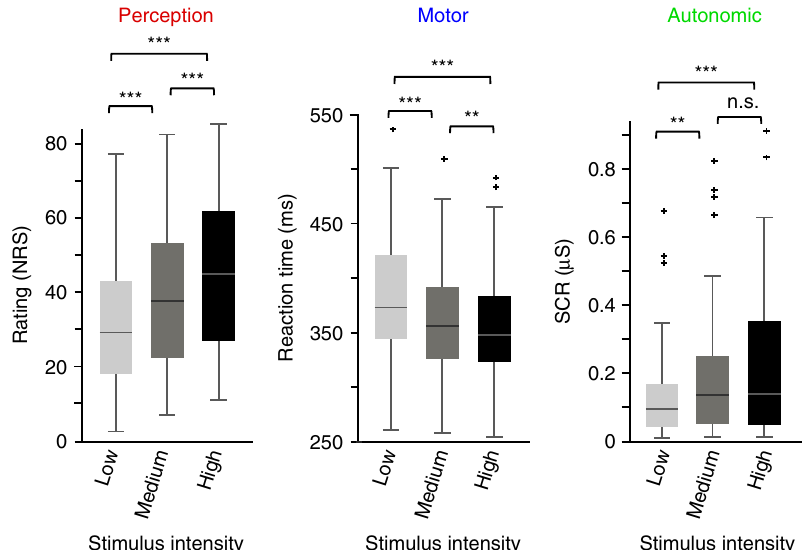
Fig. 2 Perceptual, motor, and autonomic responses to noxious stimuli. Box plots of pain ratings (0 – 100, NRS), reaction times (ms), and skin conductance responses ( µ S) to noxious stimuli of low, medium, and high intensity in the perception, motor, and autonomic conditions, respectively. The band inside the box indicates the median, and the bottom and top edges of the box indicate the 25th and 75th percentiles, respectively. The whiskers extend to the most extreme data points not considered outliers, and the outliers are plotted individually using the “ + ” symbol. ** p < 0.01, *** p < 0.001, n.s. not signi fi cant, dependent samples t -tests; NRS numerical rating scale, SCR skin conductance